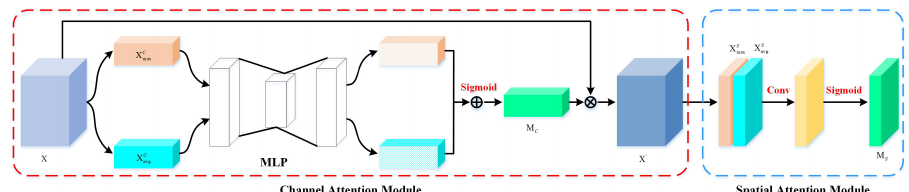
Figure 4. Diagram of the channel–spatial attention